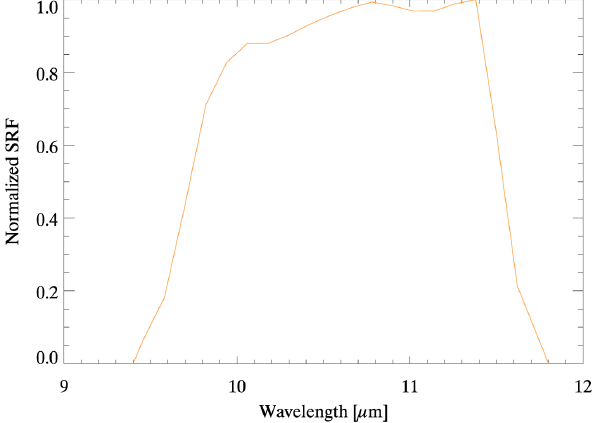
Figure 1. The spectral response function of the infrared radiometer installed on top of the ground-based microwave radiometer, at the range of 9.4–11.8µm (Morris, 2006). The estimated center wave- length for the given spectral response function is about 10.6µm.